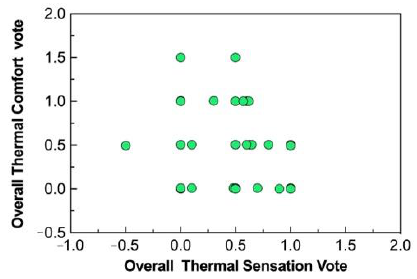
Figure 11. Changes in the OTSV and OTCV.